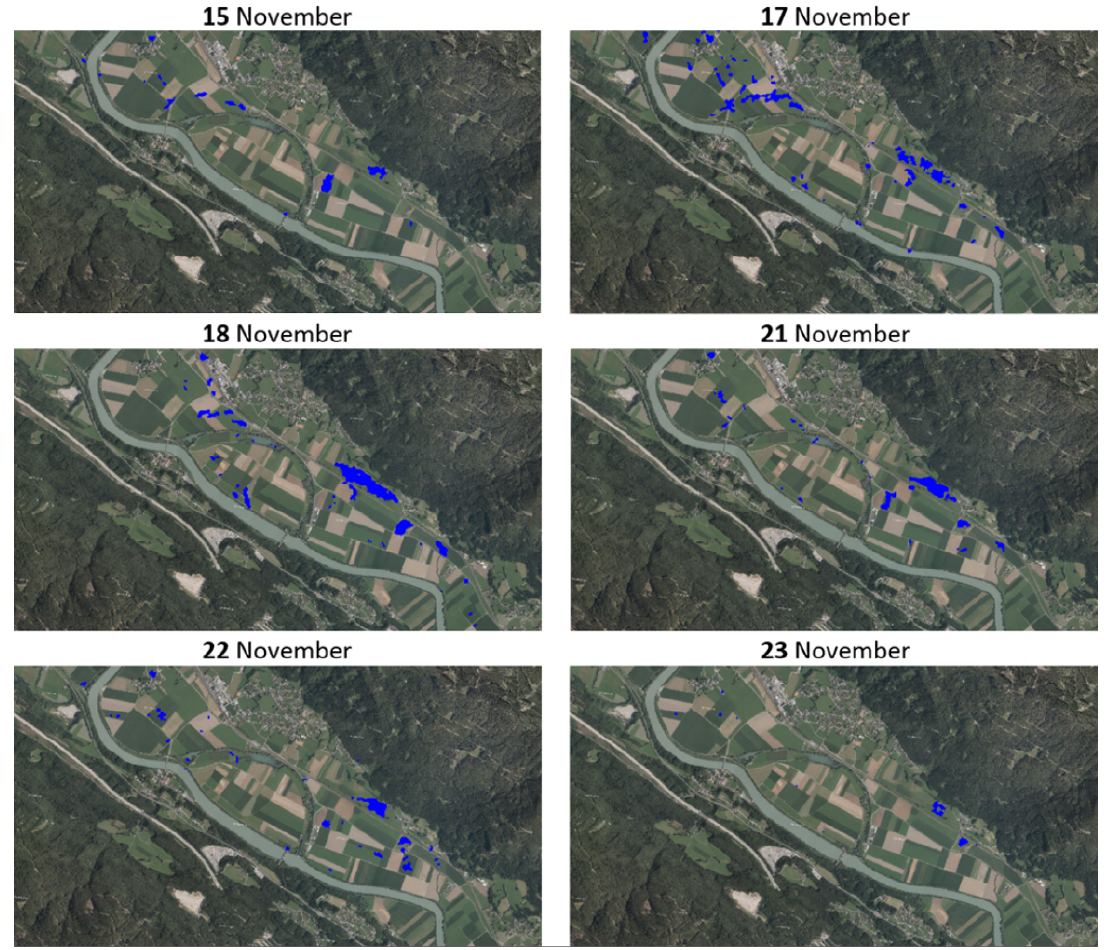
Figure 6. Progression of the November 2019 flooding along the river Drau near Weißenstein in Carinthia for the period 15 to 23 November 2019. The flood extent maps were derived from a sequence of six Sentinel-1 images by comparing each SAR image (in VV polarisation) to a Sentinel-1 composite image depicting normal (i.e. non-flooding) conditions during this part of the year. The images show an overlay of the Sentinel-1 derived water extent maps on top of a Sentinel-2 image. The SAR differences images were post-processed (filtered, classified) and cleaned for